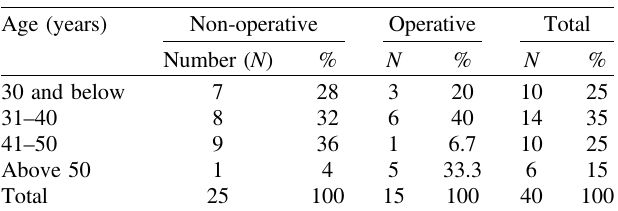
Figure 2. (a) Clavicle fracture, (b) postoperative x-ray after 3 months, (c) fracture union with good results and (d) after implant removal at 1 year. Table 1. Age distribution. Table 2. Fracture union time and